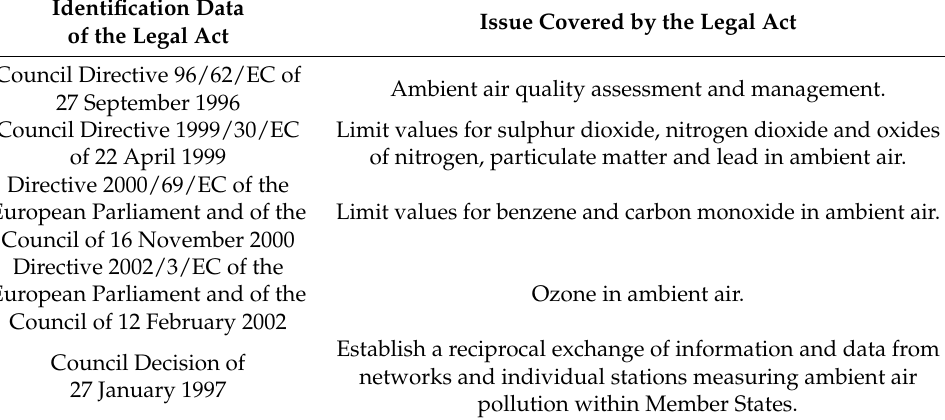
Table 1. Provisions of the legal acts [5,8,14,29].